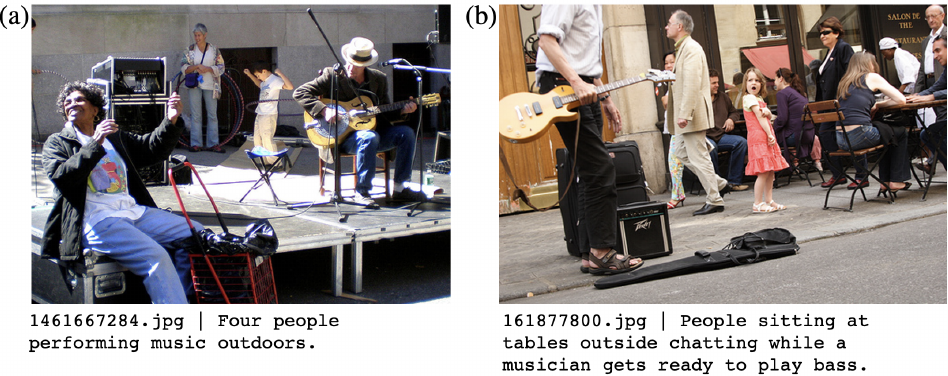
Figure 19. Example images with corresponding annotations from the Flickr30k